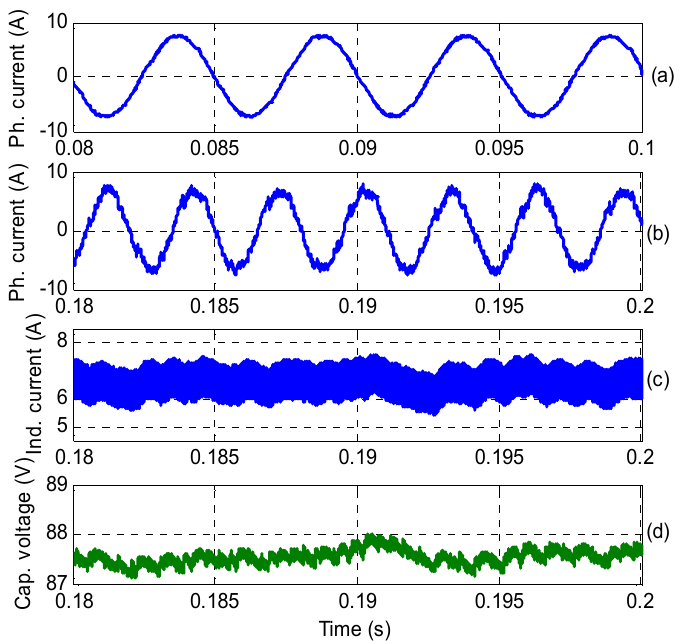
Figure 11. Steady-state performance of the modulated MPC at a sampling time of 20 µ s: ( a ) phase current below the base speed, ( b ) phase current above the base speed, ( c ) inductor current in boosting mode, and ( d ) capacitor voltage above the base speed.